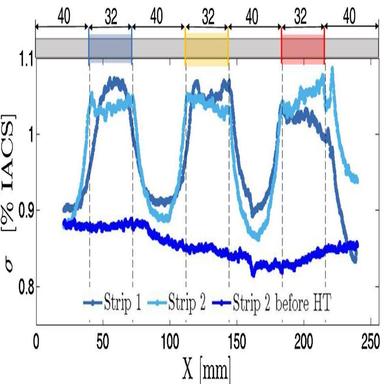
Electrical conductivity profile of FGM using four-point probe testing at room temperature.